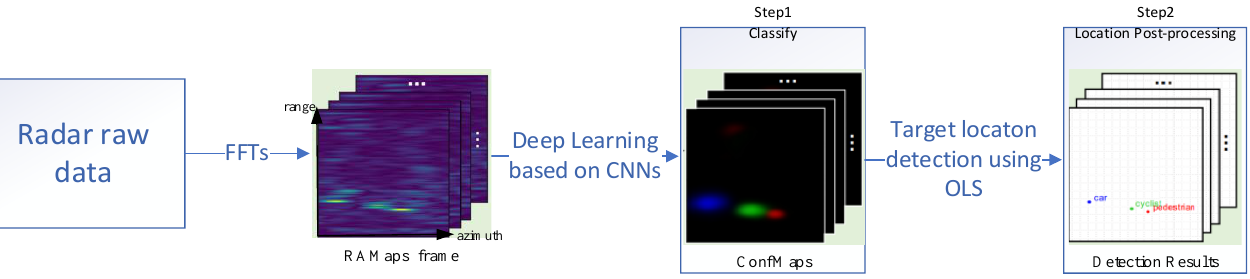
Figure 2. RODNet radar data target-detection flow chart [25]. For radar RA image and the ConfMap predicated by RODNet, their horizontal and vertical coordinates are radar azimuth and range in meter, and every image size is 128 × 128. Each coordinate corresponds to a grid.